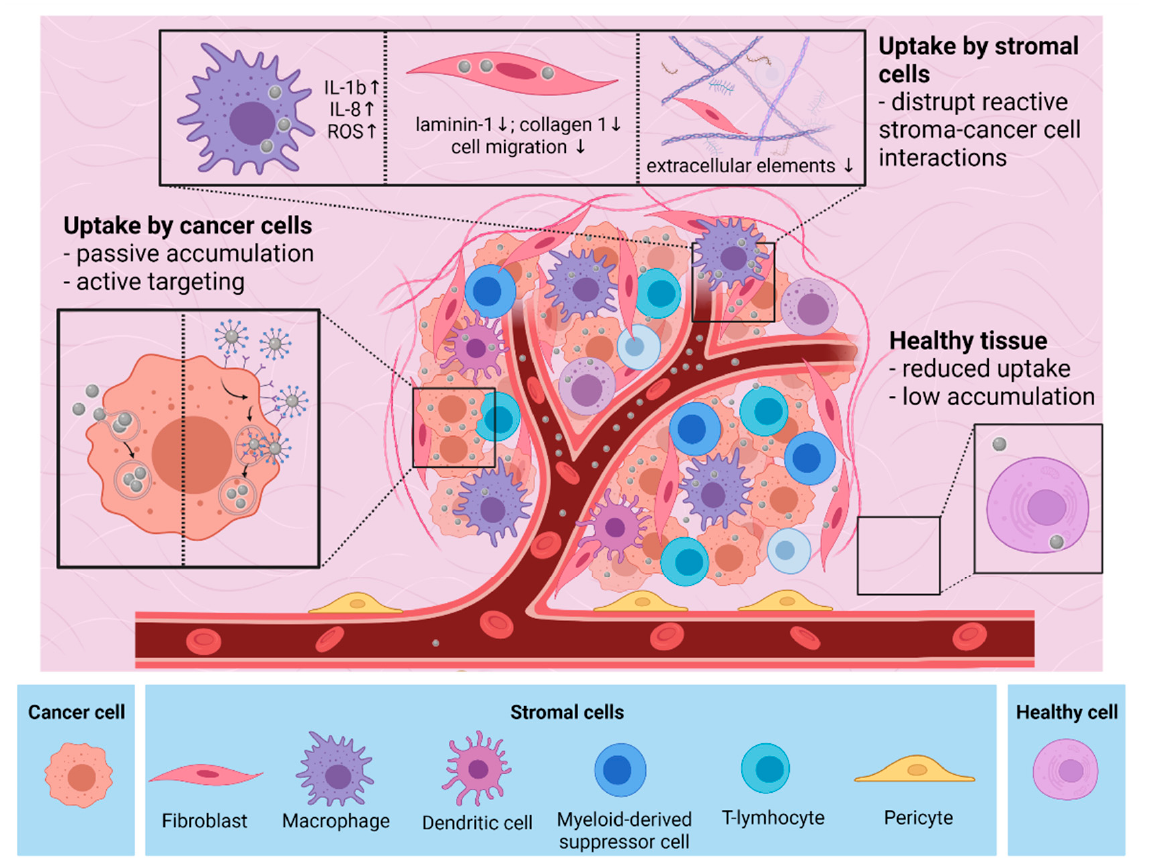
Figure 2. Interactions of AgNPs with cancer and stromal cells of the tumor tissue and with healthy cells. AgNPs are accumulated in tumor tissue passively or can be targeted to the tumor actively. AgNPs affect the stroma-cancer cell communication. Reduced accumulation of nanoparticles is observed in healthy tissues. The figure was created with